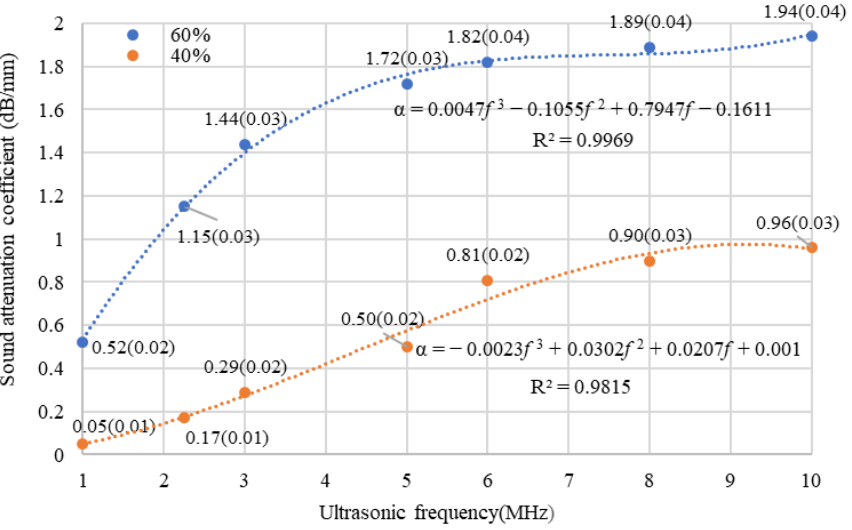
Figure 17. Relationship between the ultrasonic attenuation coefficient and frequency of the RDX/Estane RVE model.